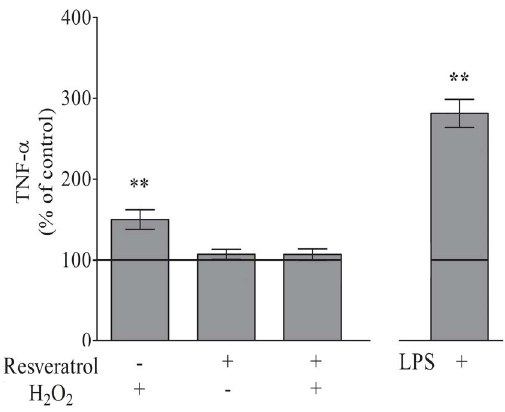
Figure 8. Astrocyte responses to inflammatory stimuli. The culture medium was removed, followed by the addition of DMEM/F12 supplemented with 5% FBS, and the cells were pre-treated with resveratrol (50 m M) for 1 h. After the pre-treatment, H 2 O 2 (50 m M) was added for 3 h in the presence or absence of resveratrol. Cells were also treated with LPS (10 m g/ml) for 3 h. The data represent the mean 6 S.E. from 3 experimental determinations performed in triplicate. ** P , 0.01 indicates significant differences from the control value.